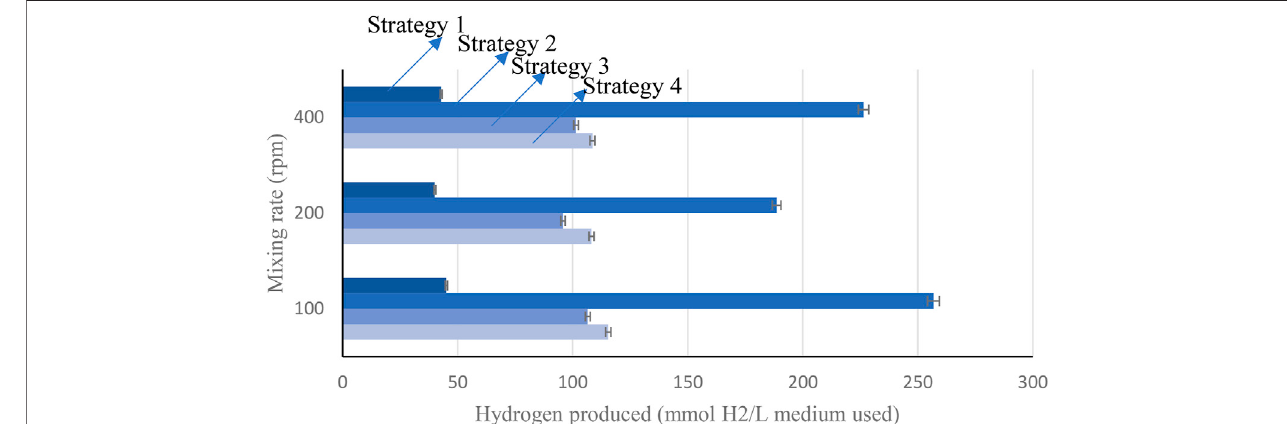
FIGURE 12 | Hydrogen gas produced.